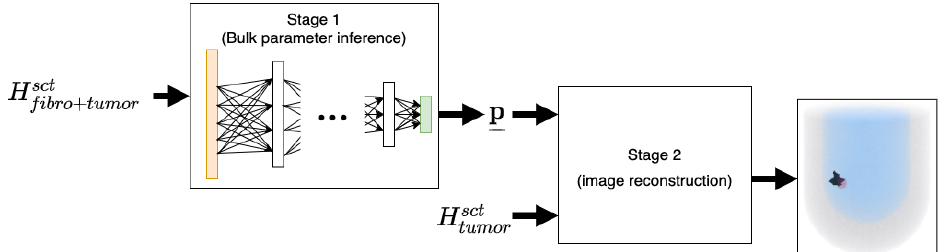
Figure 2. Bulk parametric inversion of scattered-field data to recover prior information (our vector of parameters p ), followed by data-to-image reconstruction using neural network recovered prior